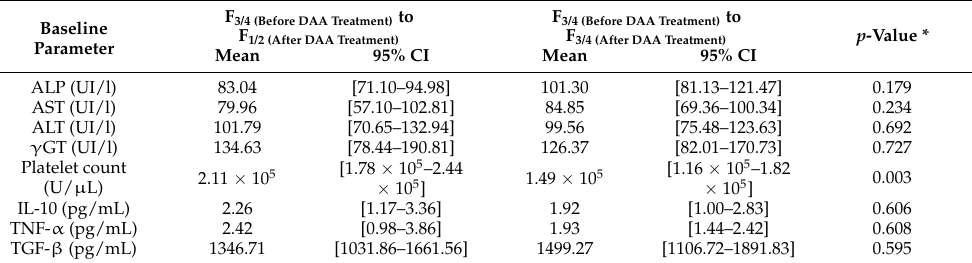
Table 6. Comparison of baseline biochemical and cellular parameters and cytokines (continuous variables) between patients whose liver fibrosis improved and those whose did